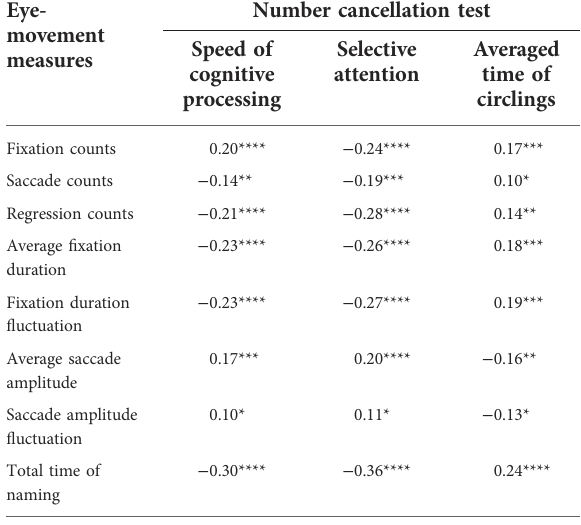
TABLE 6 Correlation between number-cancellation-related skills and eye-movement measures in task N-color.